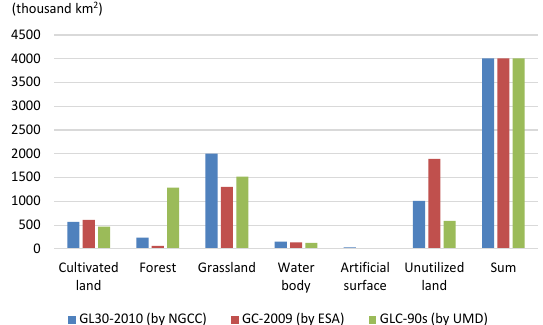
Figure 5. Area statistics and comparison with other major